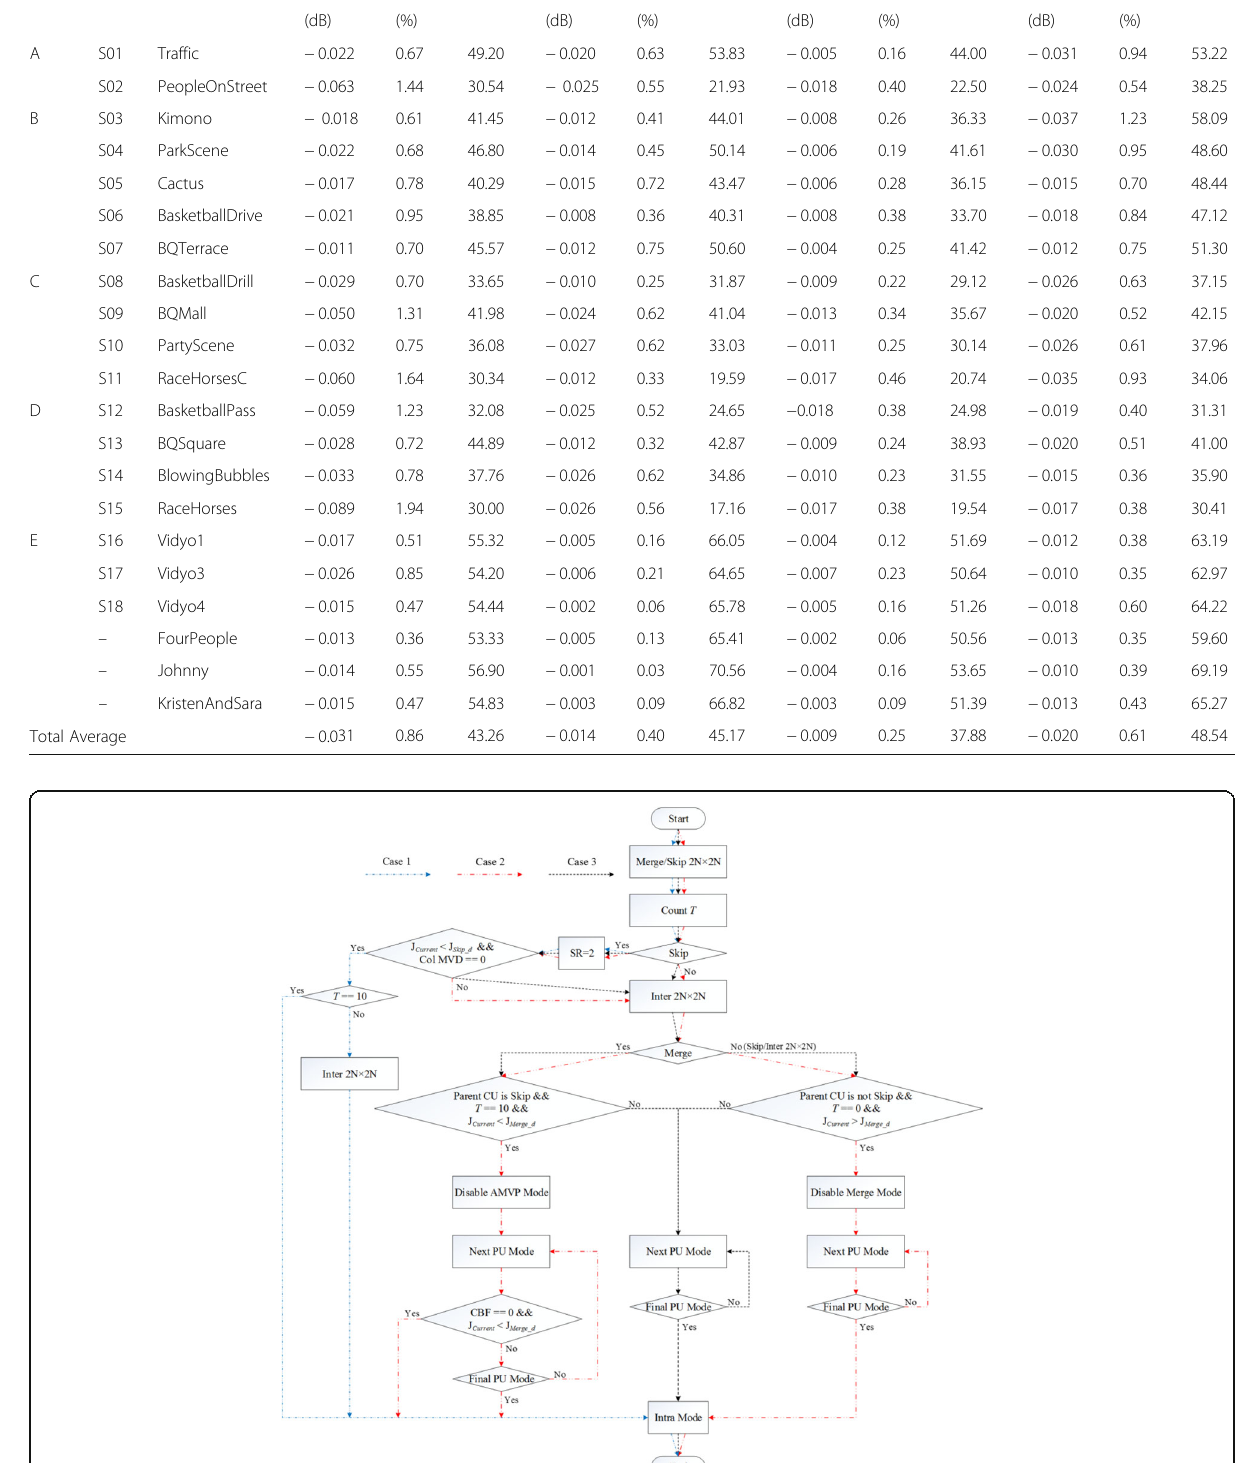
Table 6 Performance comparison with CFM [5], ECU [6] and ESD [7] under random-access configuration HM 16.4